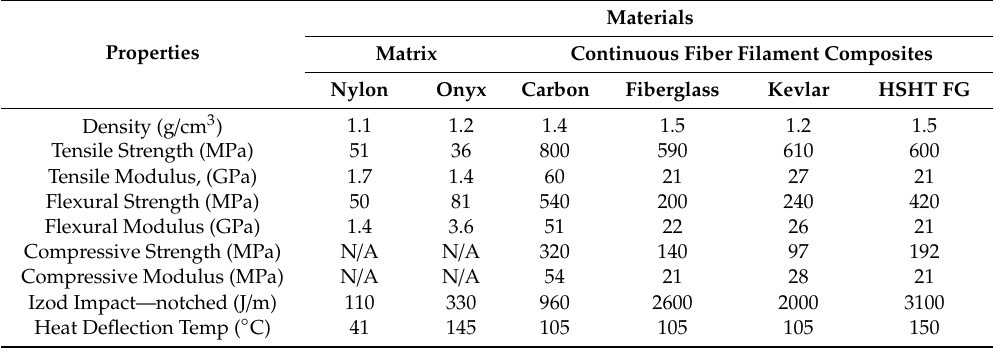
Table 1. Material specifications provided by Markforged Inc. [19].